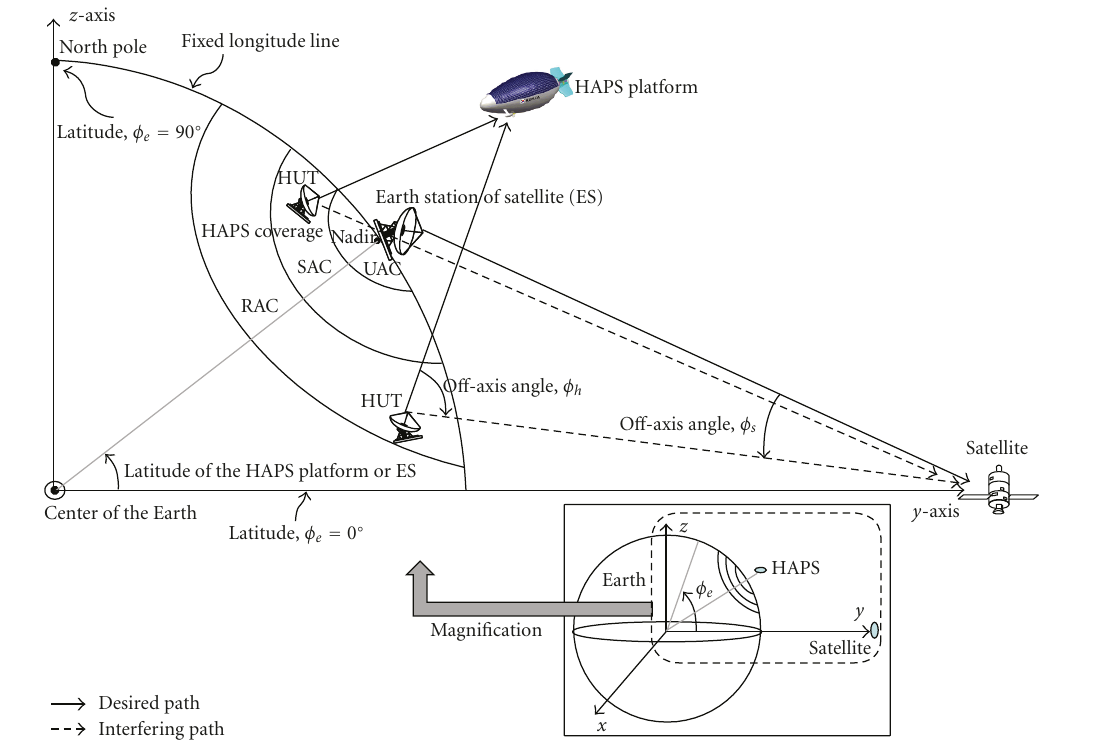
Figure 1: Description of HAPS and GEO